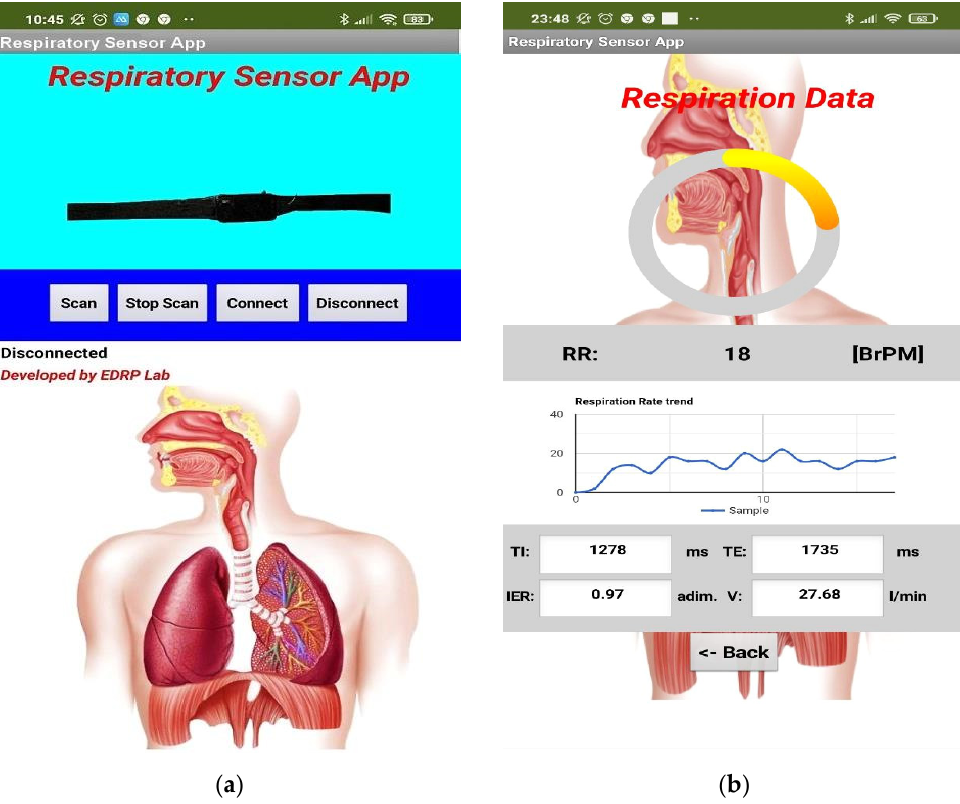
Figure 7. Screenshots of the developed Android application used to visualize the data transmitted by